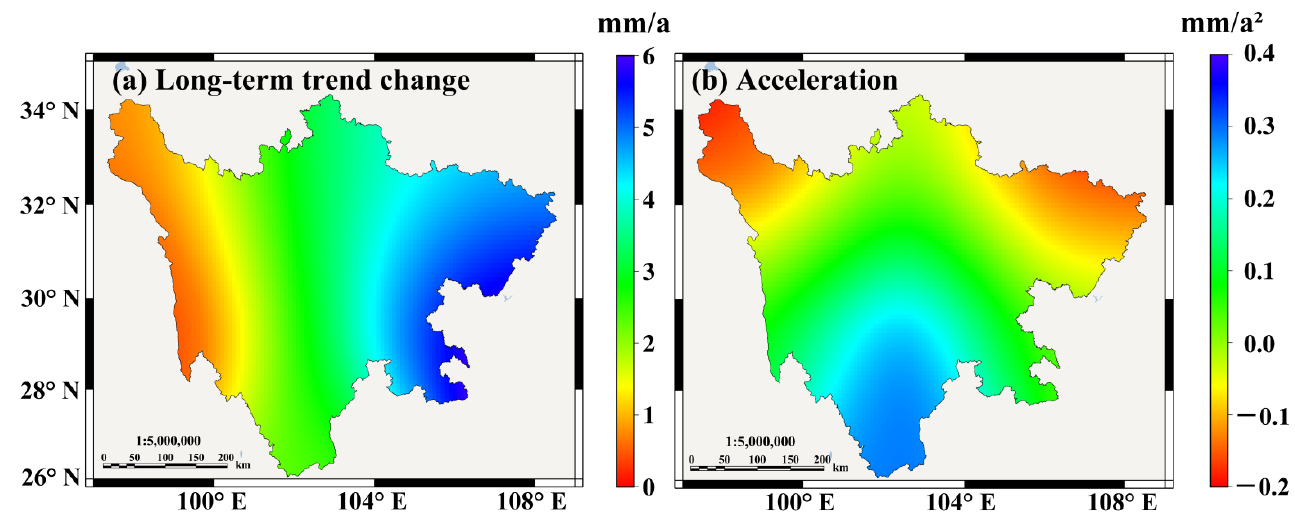
Figure 6. The spatial distribution of long-term trend changes ( a ) and acceleration ( b ) of TWSC in Sichuan Province.